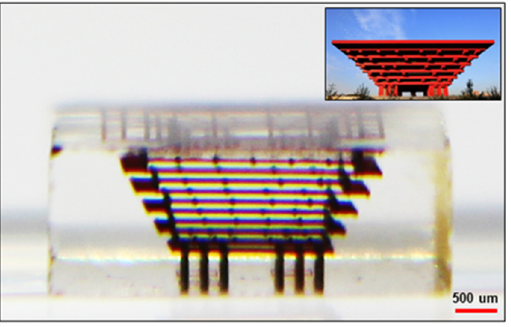
Figure 7. Images of the China Pavilion written in Foturan glass fabricated by SSTF scheme. Reproduced with permission from [31], Copyright The Optical Society, 2016.